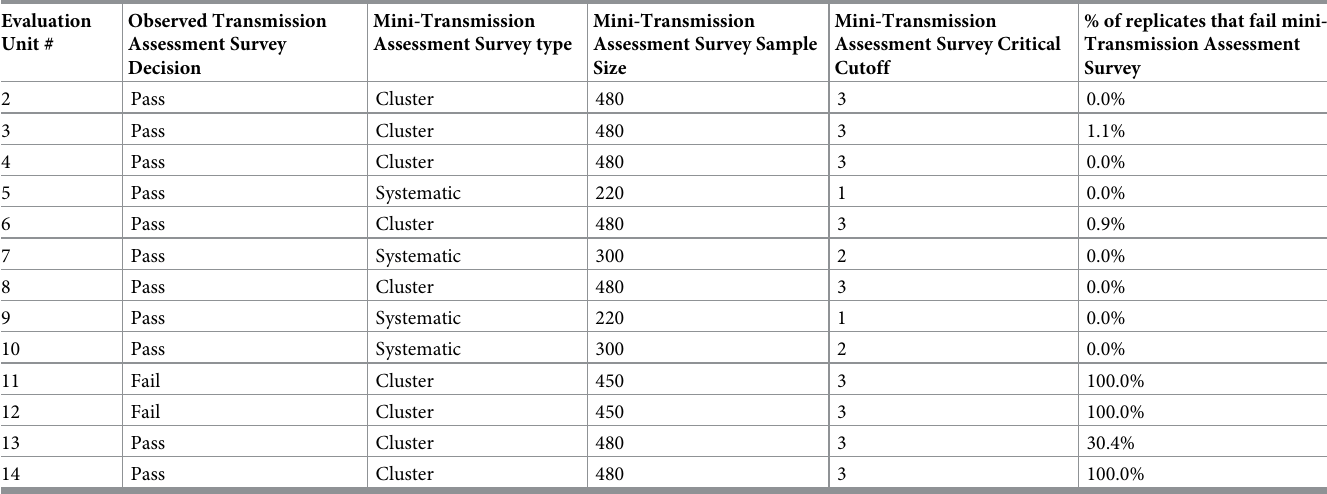
Table 4. Results of mini-Transmission Assessment Survey (mini-TAS)